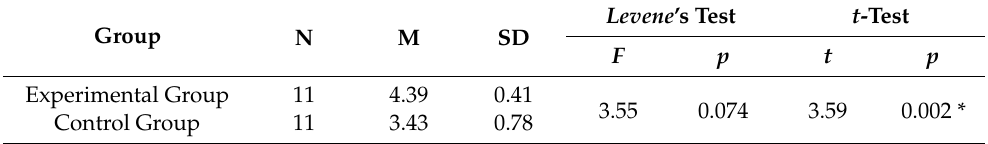
Levene ’s Test t -Test F p t p 3.55 0.074 3.59 0.002 *